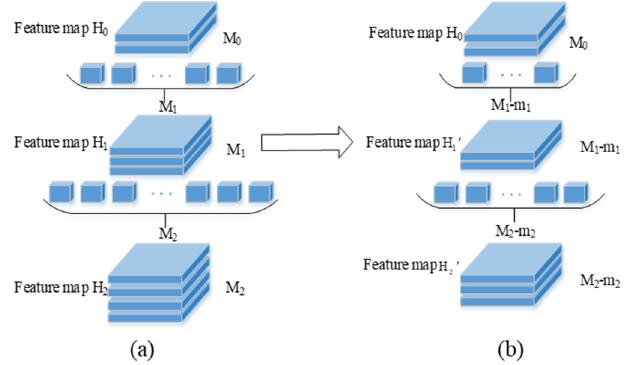
Figure 6. Pruning network model. ( a ) Before pruning. ( b ) After Pruning.